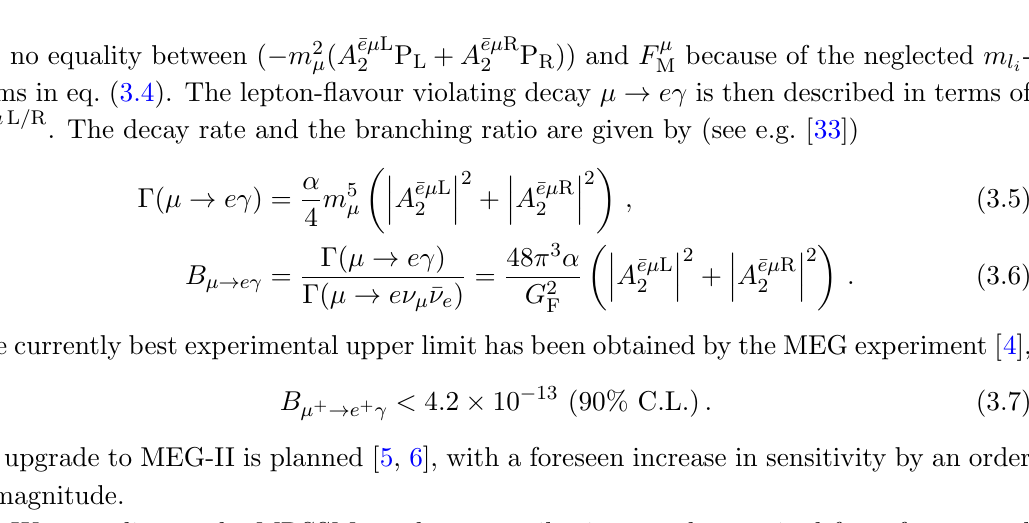
; the (cid:12)rst two also contribute to the 1